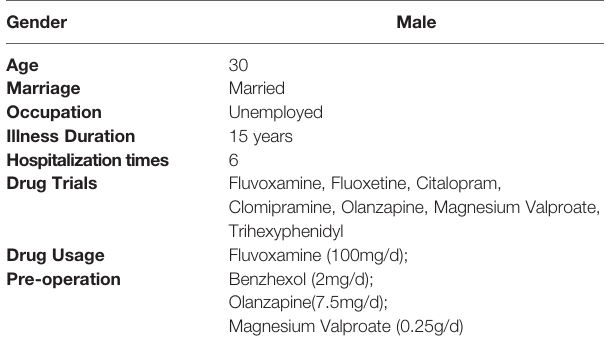
TABLE 1 | Patient's demographic and clinical